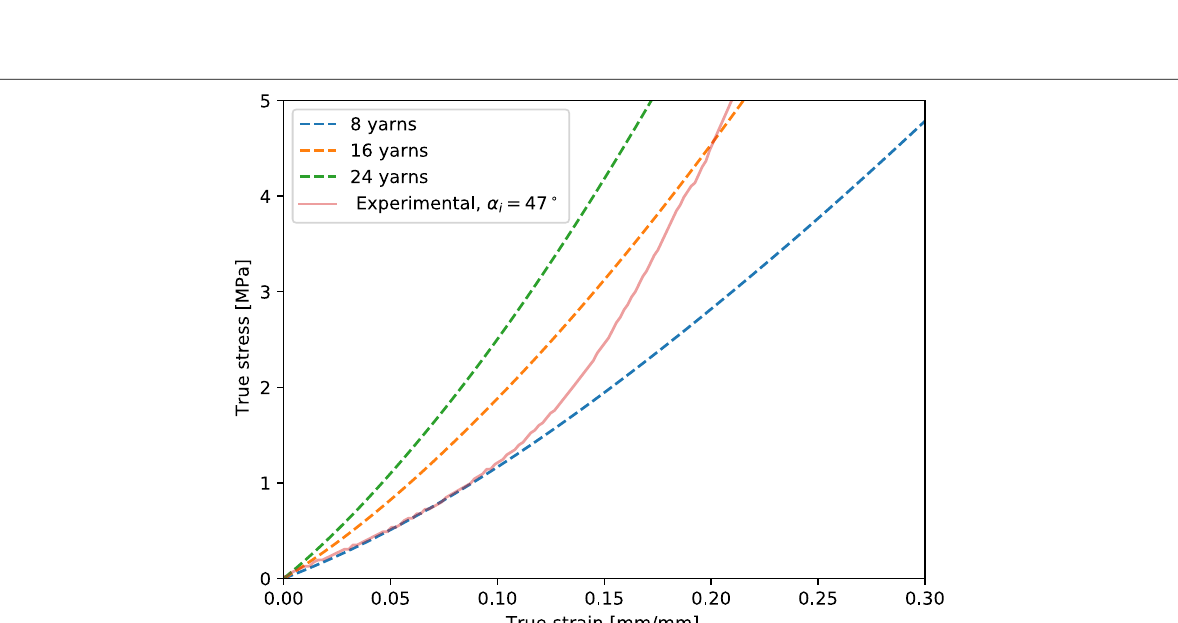
Fig. 6 Theoretical true stress–strain curves for different number of yarns compared to experimental results of braid on core where α i